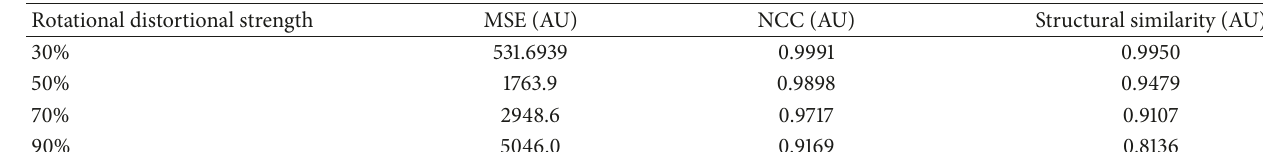
Table 2: Evaluation of registration result (rotational distortion deformation).